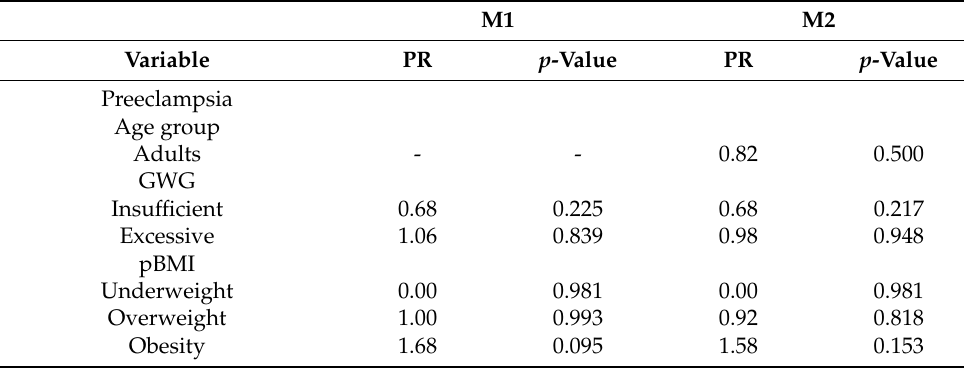
Table 3. Poisson regression models for the association of GWG and pBMI with preeclampsia, pregnancy-induced hypertension, and